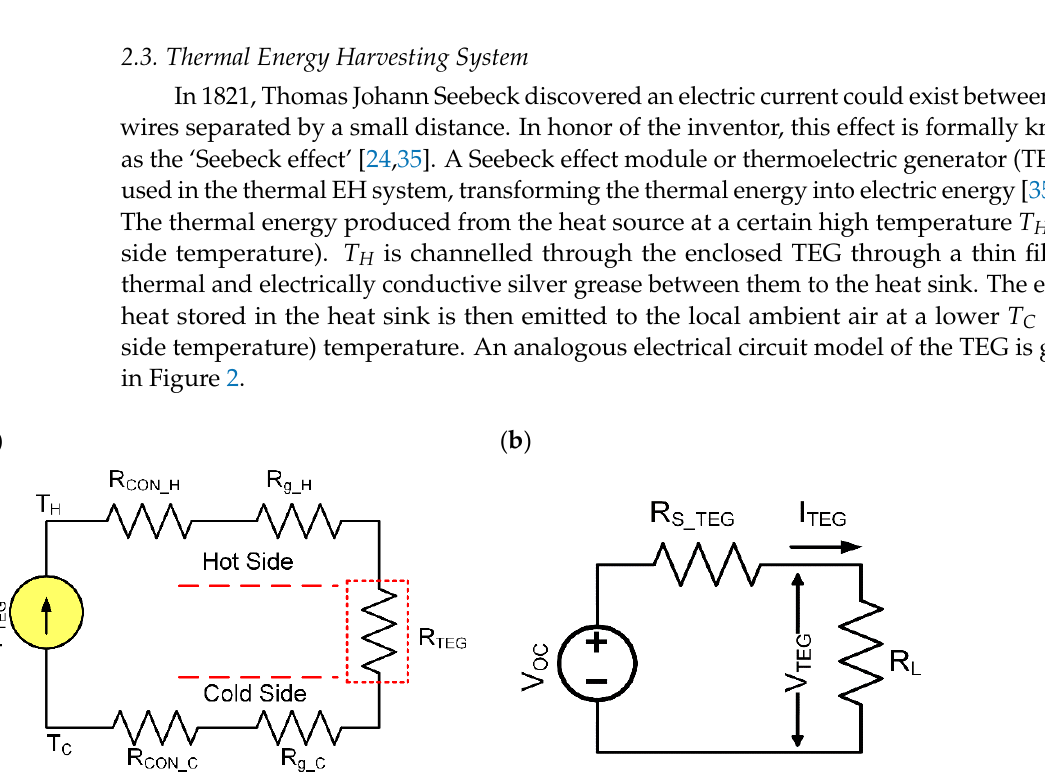
Figure 2. ( a ) Equivalent electrical circuit of TEG; ( b ) simplified circuit of TEG [15].